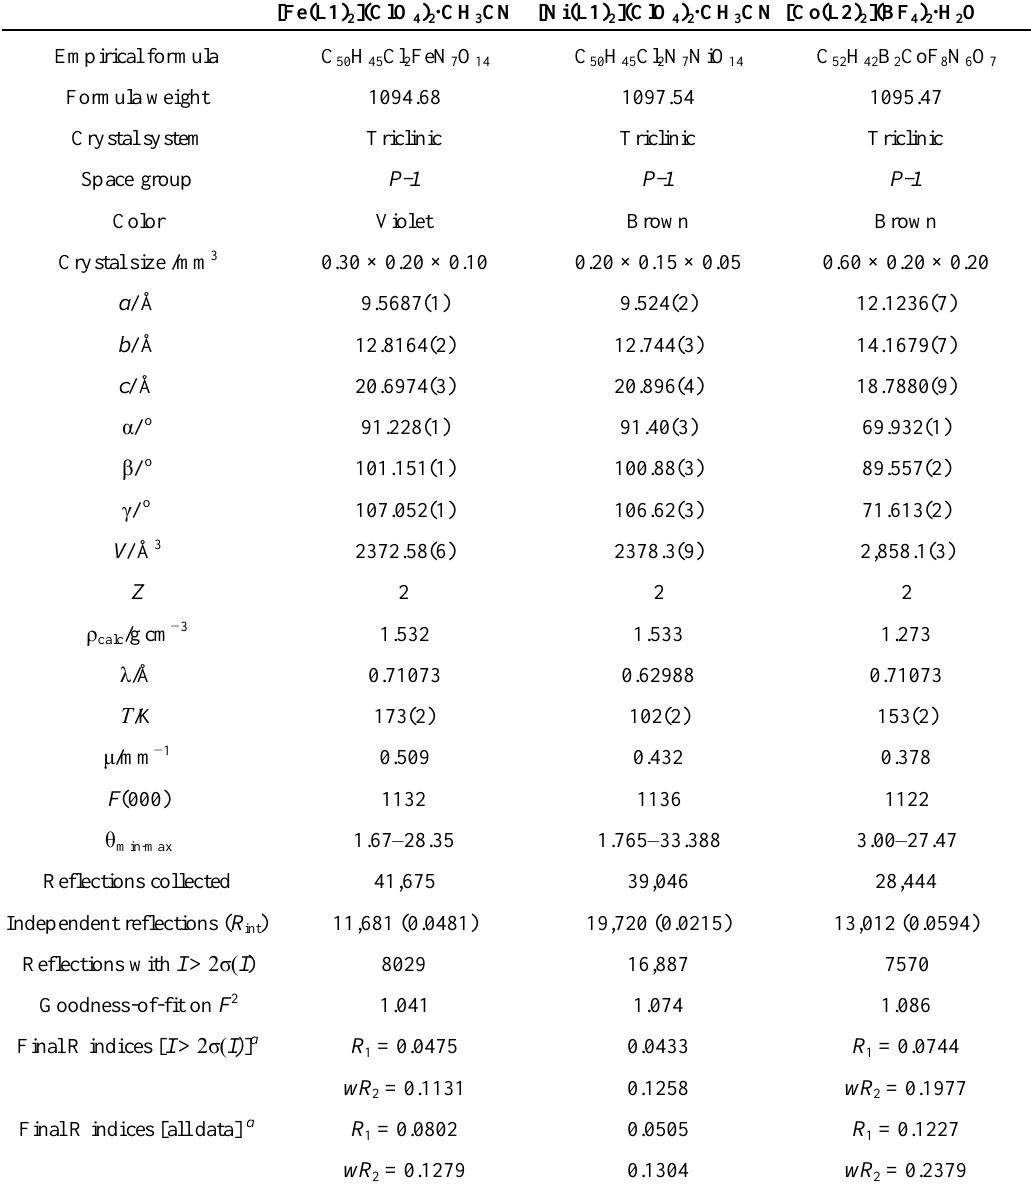
Table 2. Crystal and refinement